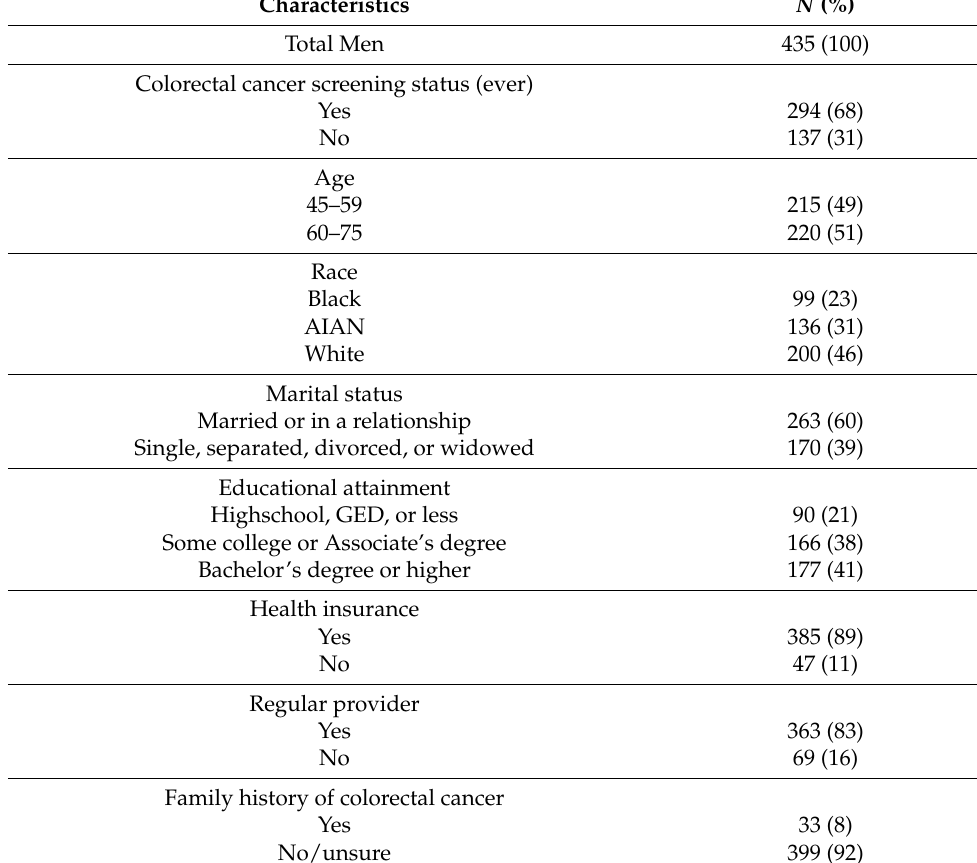
Table 1. Summary of demographic characteristics.